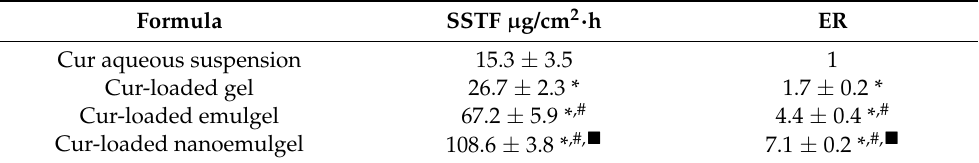
Values are expressed as mean ± SD. * p < 0.05 compared to Cur aqueous suspension. # p < 0.05 compared to Cur-loaded gel. (cid:4) p < 0.05 compared to Cur-loaded emulgel.